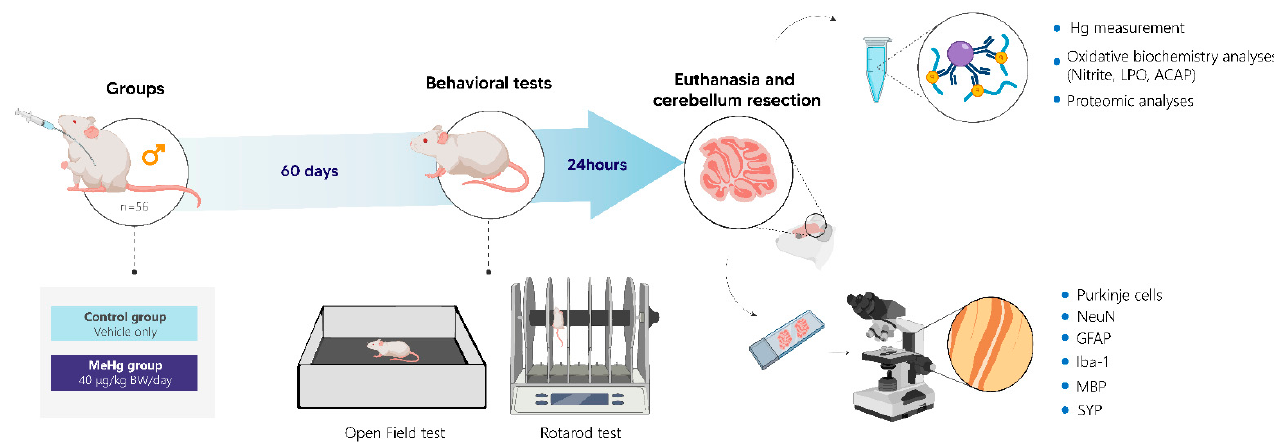
Figure 1. Methodological summary of the study. Wistar rats were divided into control (n = 27) and MeHg groups (dose of 40 µg/kg/day) (n = 27). After 60 days of MeHg exposure, the motor functions were assessed by open field and rotarod tests. Then, after cerebellum collection, the samples were processed for total mercury determination, oxidative biochemistry (antioxidant capacity against peroxyl radicals (ACAP), nitrites, and lipid peroxidation (LPO)), and proteomic and morphological analyses (Purkinje cell count, immunohistochemistry for mature neurons (NeuNs), glial fibrillary acidic protein (GFAP), microglial markers (Iba1), myelin basic protein (MBP), and synaptophysin (SYP)).